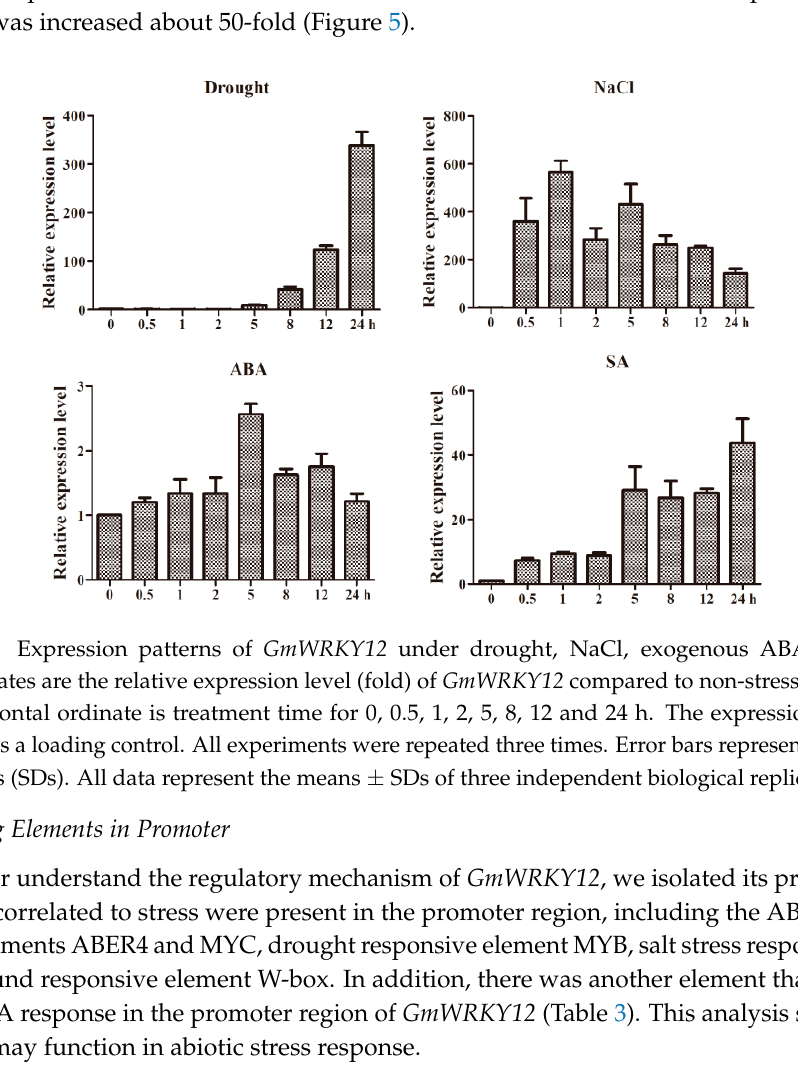
Table 3. Cis -elements analysis of GmWRKY12 promotor.